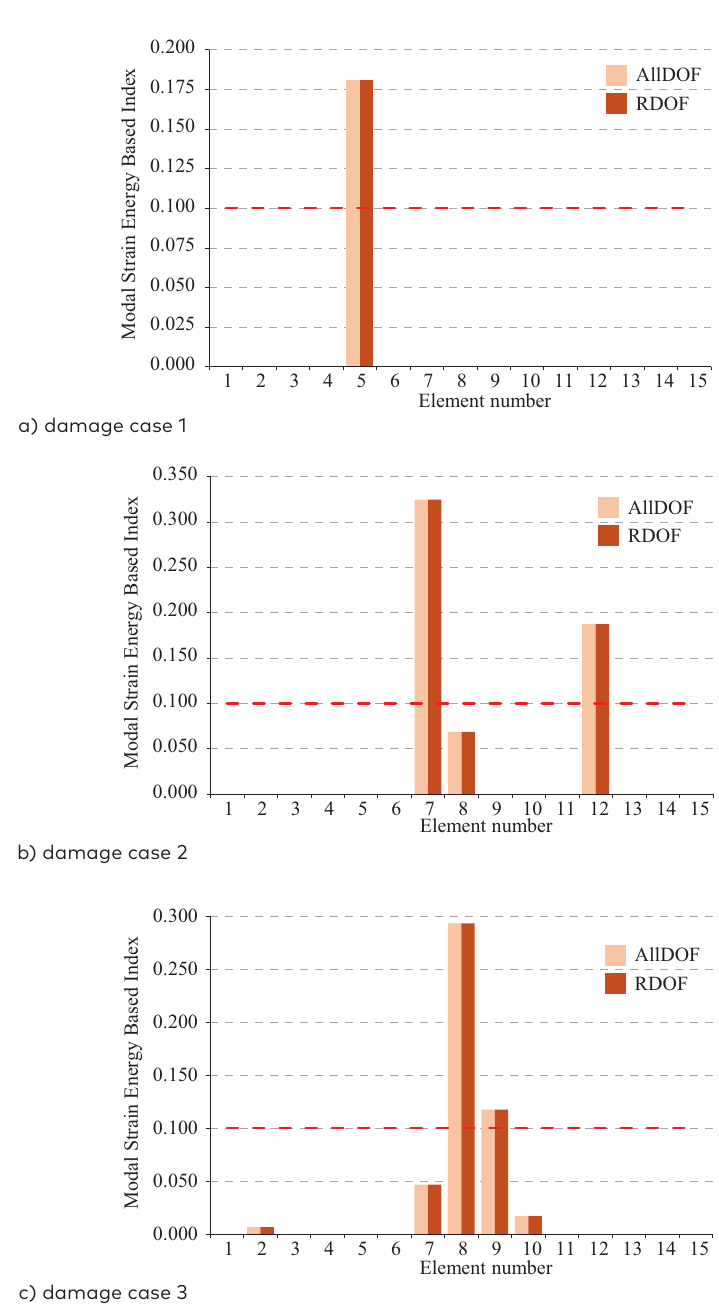
Figure 4. Damage index values in 15-element truss for four modes